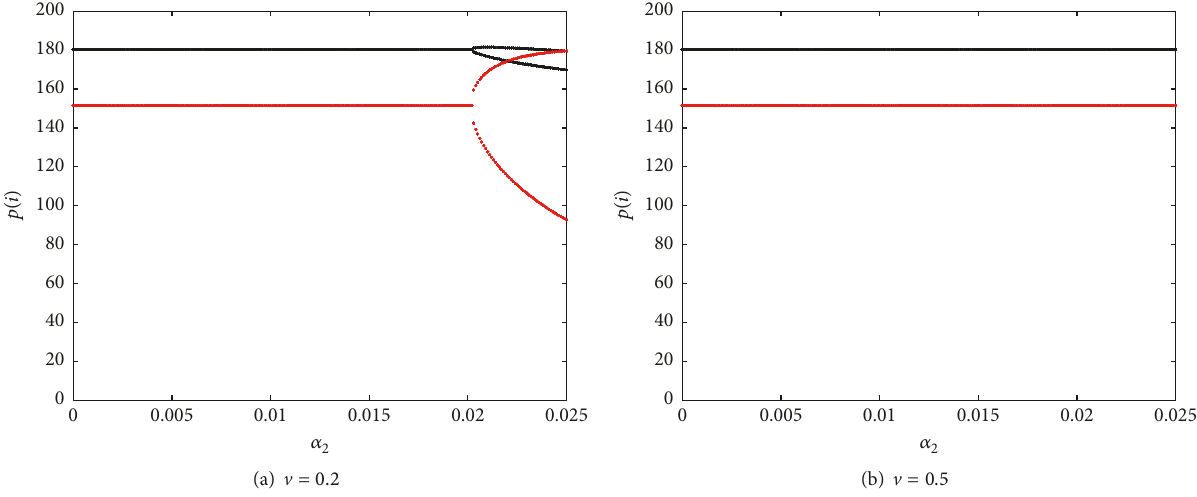
Figure 10: Bifurcation diagram with respect to 𝛼 2 , when 𝛼 1 = 0.005.